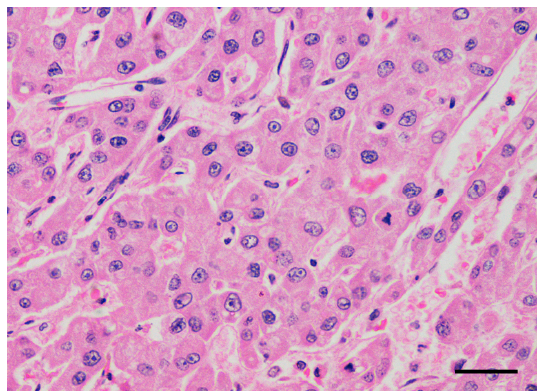
Figure 2. Dog, liver. Histological sample of hepatocellular carcinoma. At high magnification, neoplastic cells show moderate anisocytosis and anisokaryosis, prominent nucleoli and mitotic figures. Hematoxylin and eosin. Bar, 50 µm.